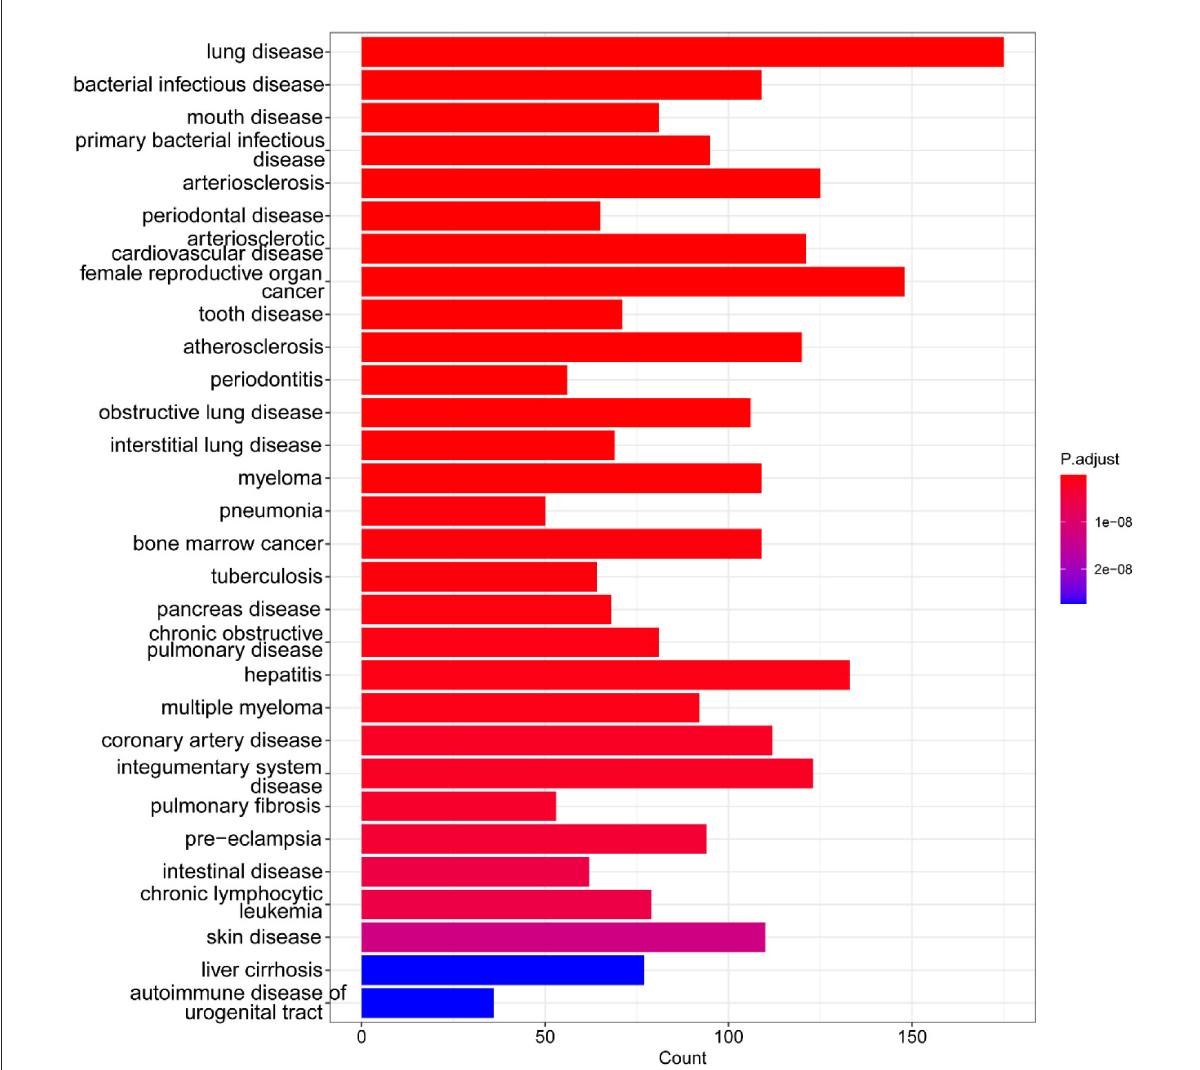
FIGURE4 DO enrichment analysis of DEGs. Bar graph of DO enrichment analyses, the lengths of the bars represent the number of enriched genes, color represents the significance, increasing gradually from blue to red. The figure shows the terms with p <